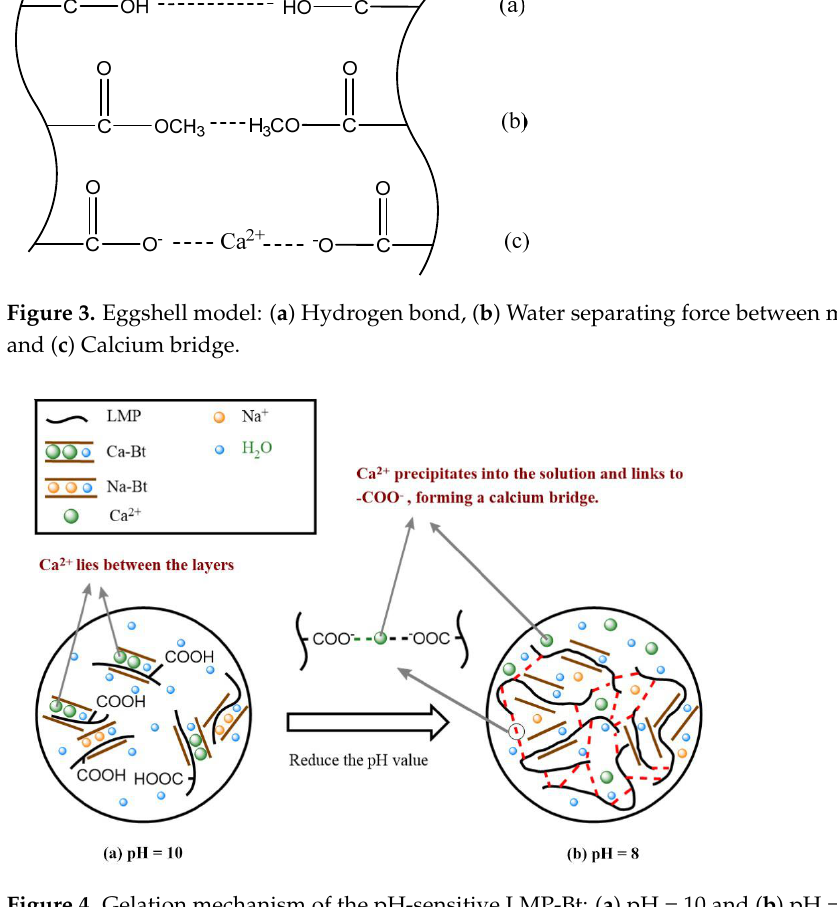
Figure 4. Gelation mechanism of the pH-sensitive LMP-Bt: ( a ) pH = 10 and ( b ) pH = 8.